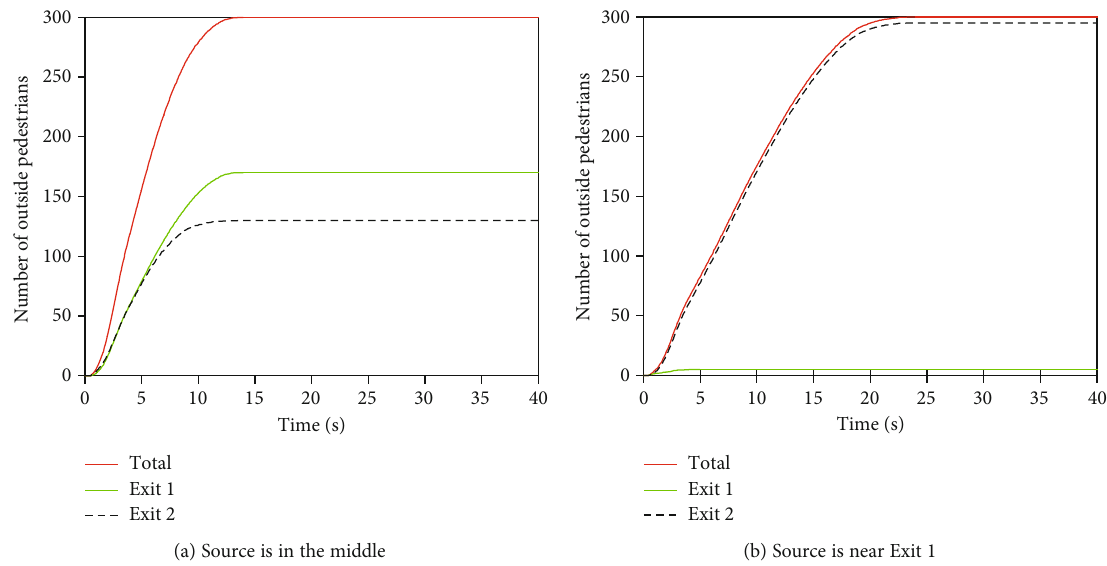
Figure 2: Number of outside pedestrians in scenario (i) and scenario (ii). The total number of pedestrians is 300.